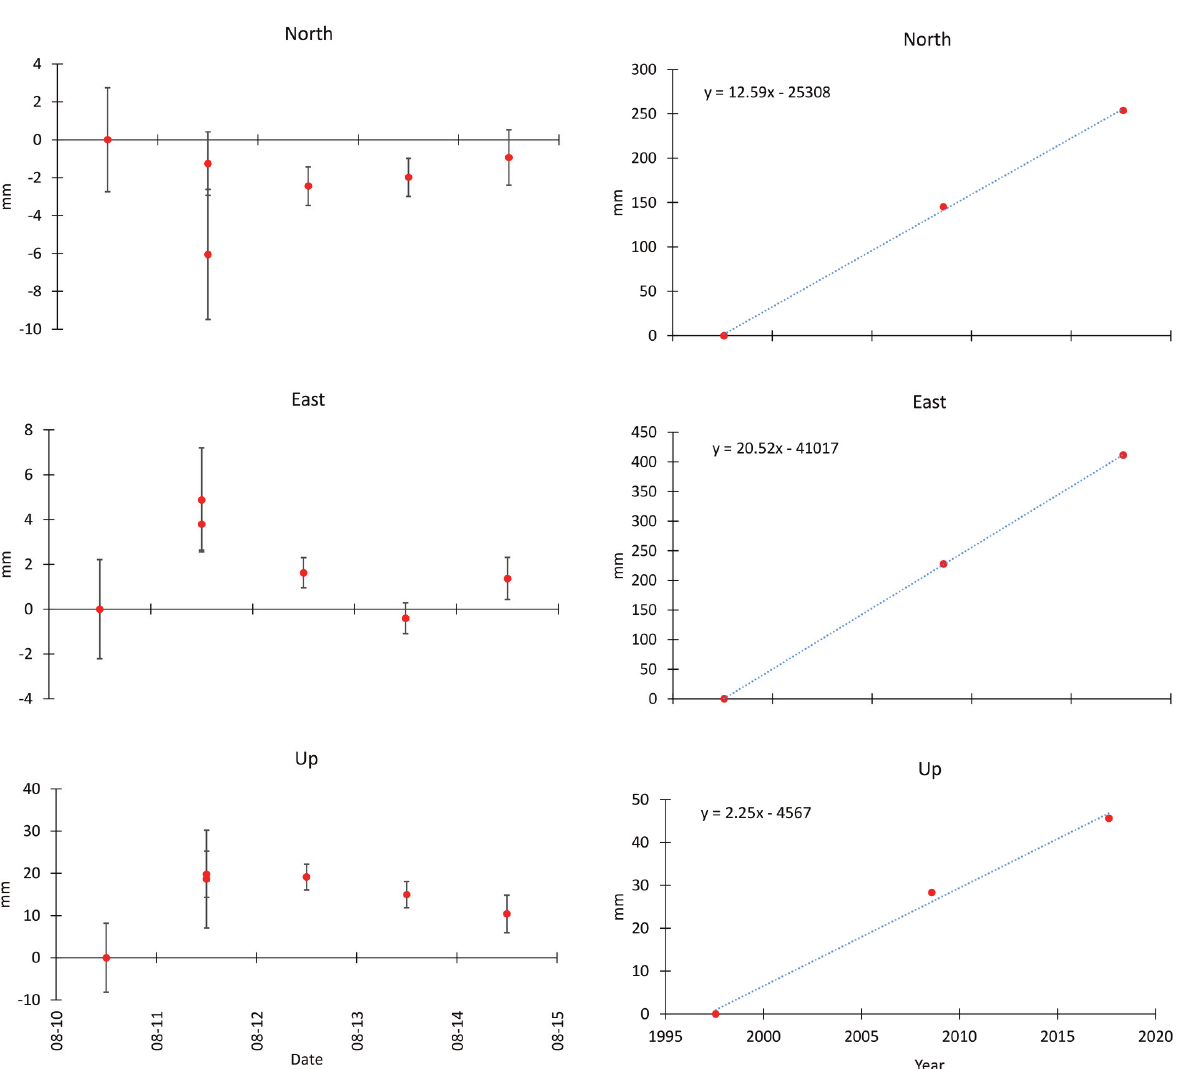
Fig. 3. The coordinate time series of the GRN point OJAKÜLA97 (Fig. 1) from three GNSS campaigns in 1997, 2008 and 2017 and velocities of the point from weighted linear regression in North, East and Up